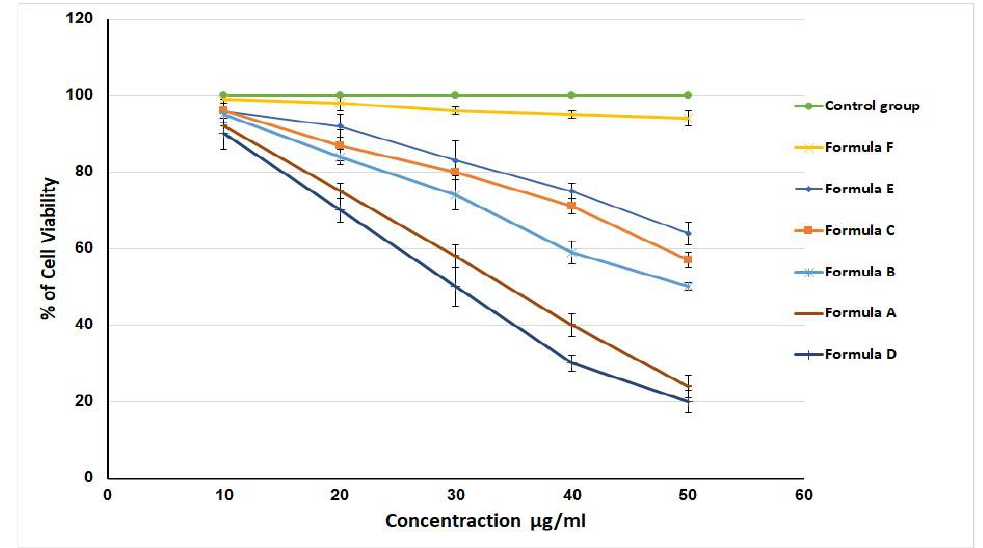
Figure 10. Effect of different LV formulations and 5-fluorouracil (control) on the viability of the HSC3 cell line. The values represent the mean ± SD of three independent experiments ( n = 9).